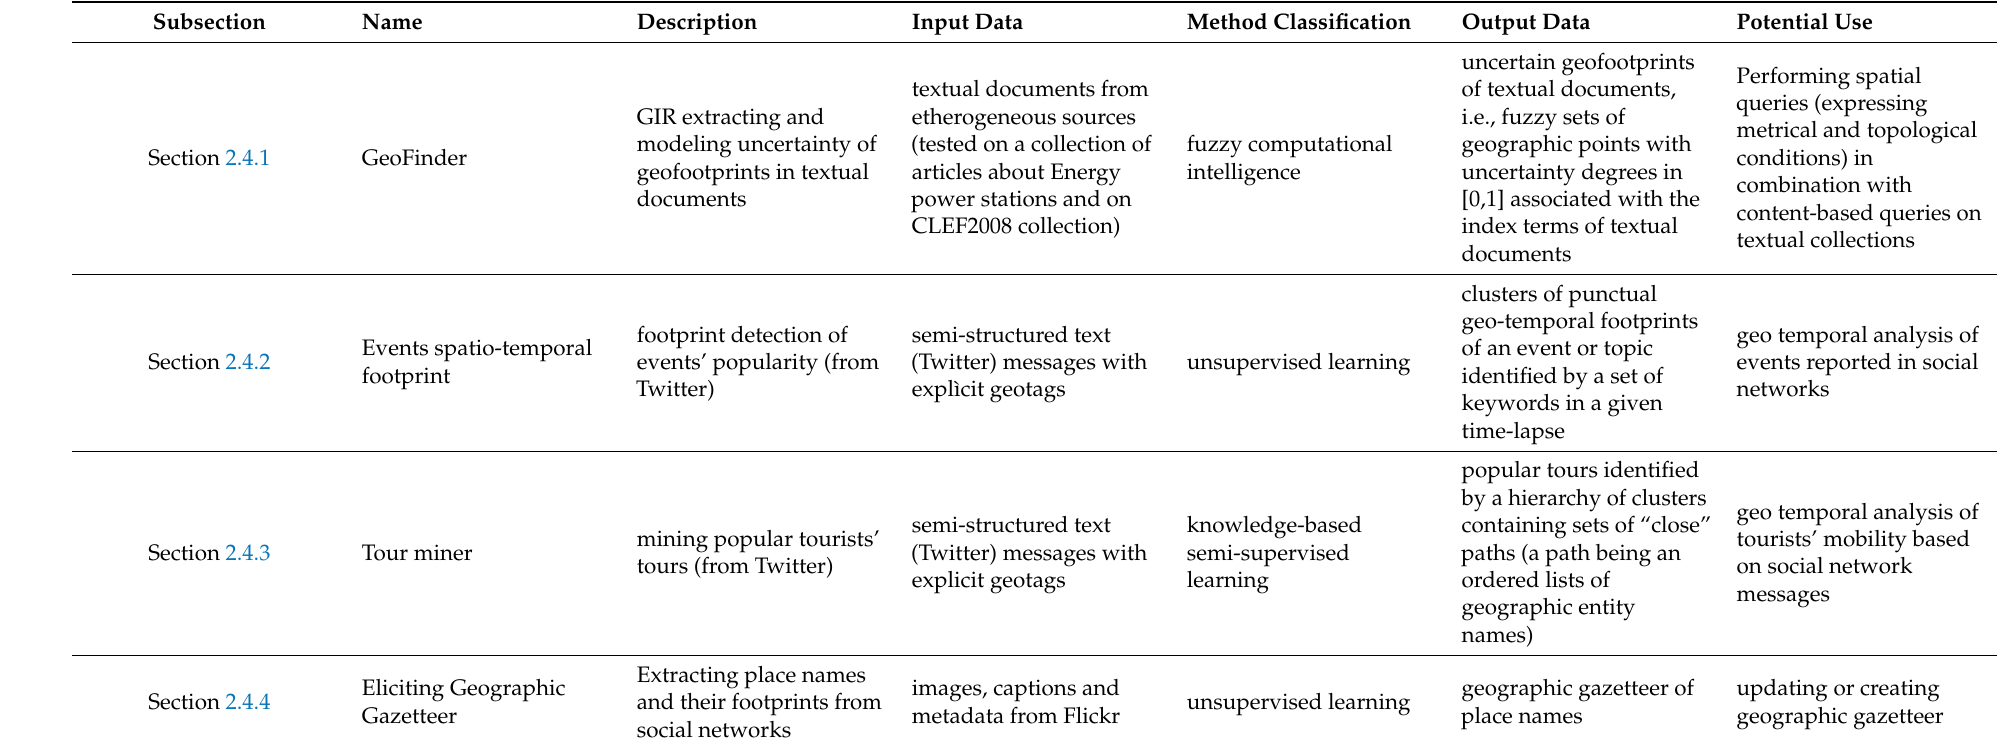
Table 1. Dimensions of case studies (Implicit